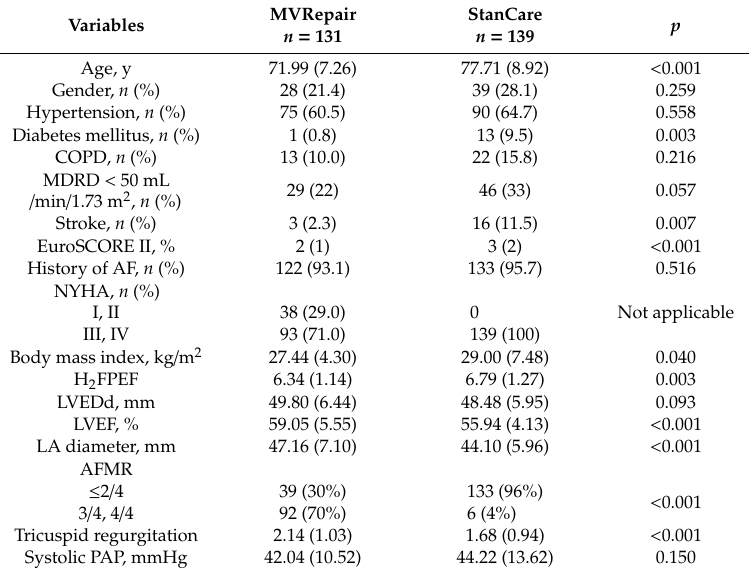
Table 1. Unadjusted baseline clinical and echocardiography